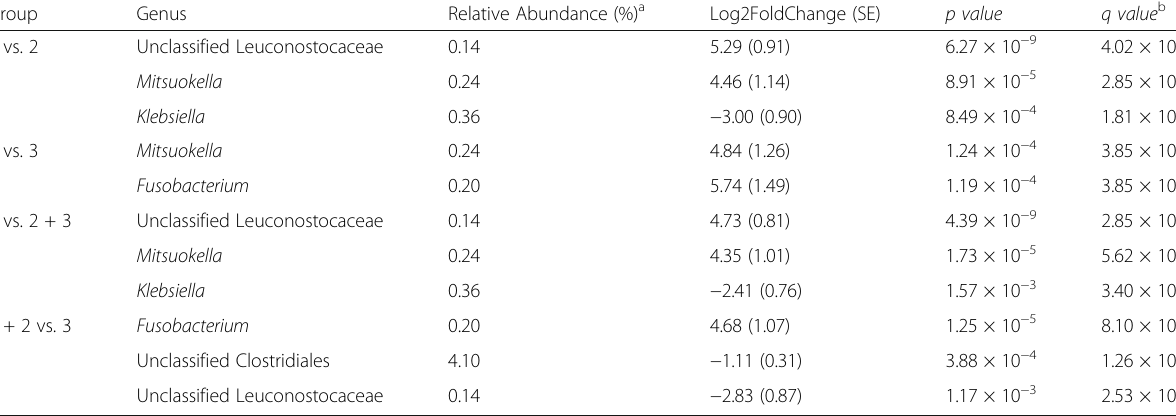
Table 2 Differing abundance of specific populations of gut microbiota among groups for intestinal 18 F-FDG uptake at the level of genus Group Genus Relative Abundance (%) a Log2FoldChange